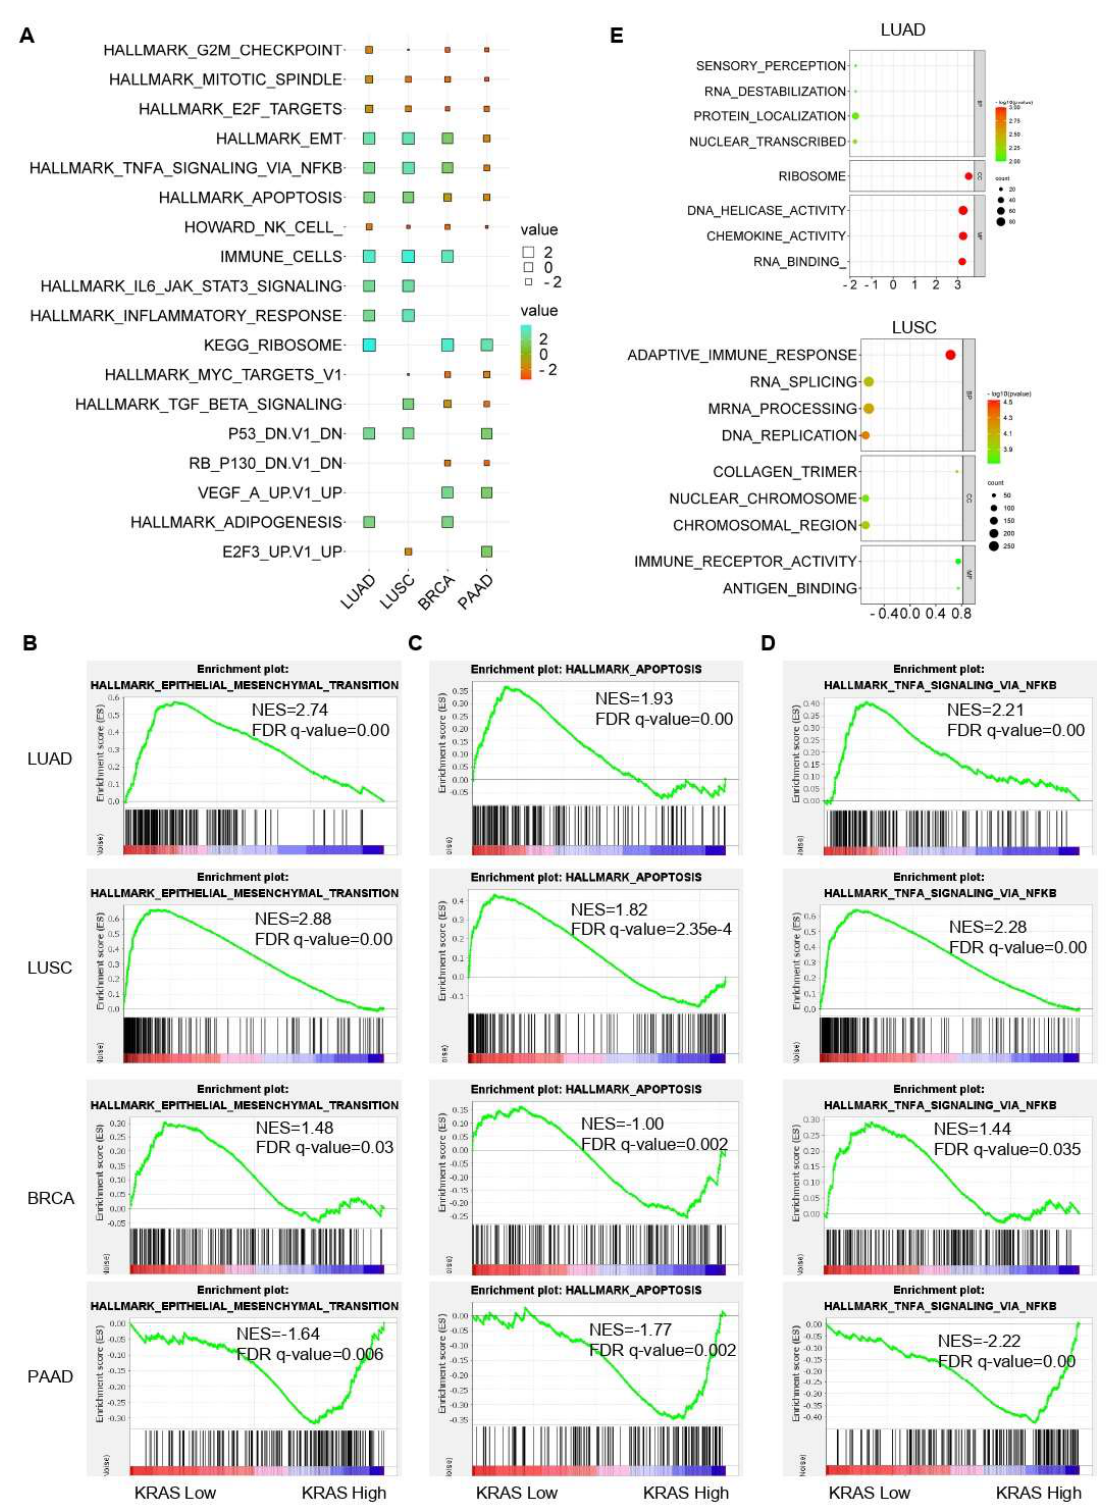
Figure 10. Gene signature analysis of KRAS-Low vs. KRAS-High datasets in LUAD, LUSC, BRCA, and PAAD. ( A ) Common gene signatures among different cancer types. ( B – D ), EMT ( B ) apoptosis ( C ) and TNF α /NF κ B signaling ( D ) are enriched in LUAD, LUSC, BRCA, and PAAD. E, Bubble plots showing the Gene Ontology of KRAS-low vs KRAS-High datasets in LUAD (top) and LUSC (bottom). A FDR q -value < 0.05 was considered a significant threshold.